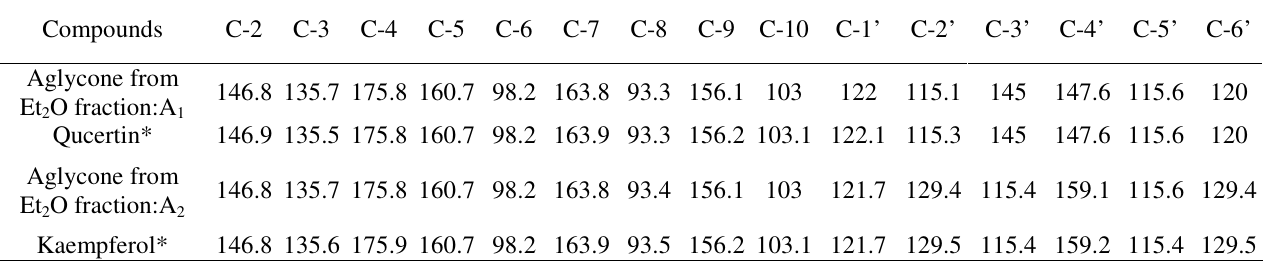
Table 3. 13 C NMR data and signal assignments for the aglycone from the flowers of Thevetia peruviana (* Values from literature)